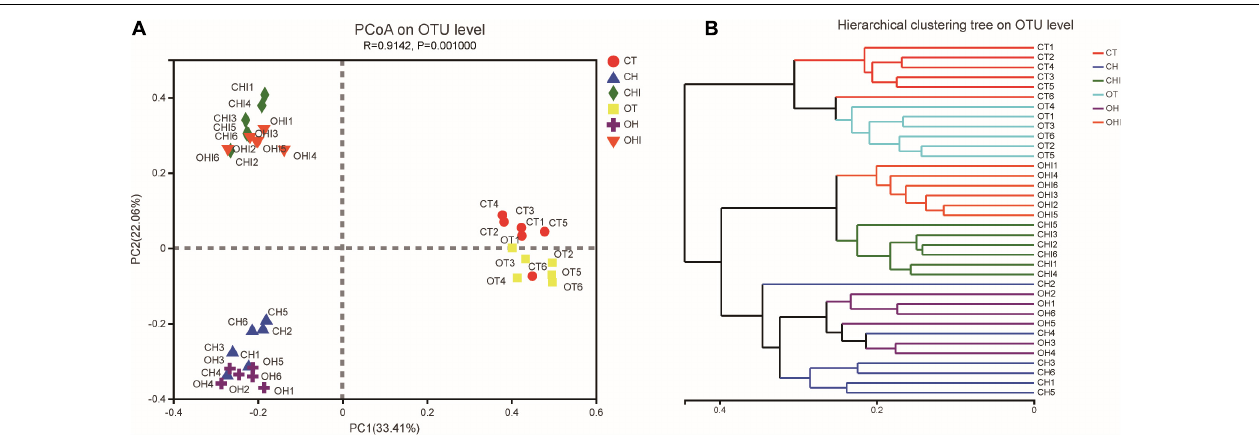
FIGURE 2 | The sectionalization of cecal microbiota. (A) Principal coordinate analysis (PCoA) of 16S sequences from 36 cecum content samples of six treatments based on Weighted Unifrac. (B) Hierarchical cluster tree of cecal microbiota. The length between the branches represents the distance between the samples, and different groups can be presented in different